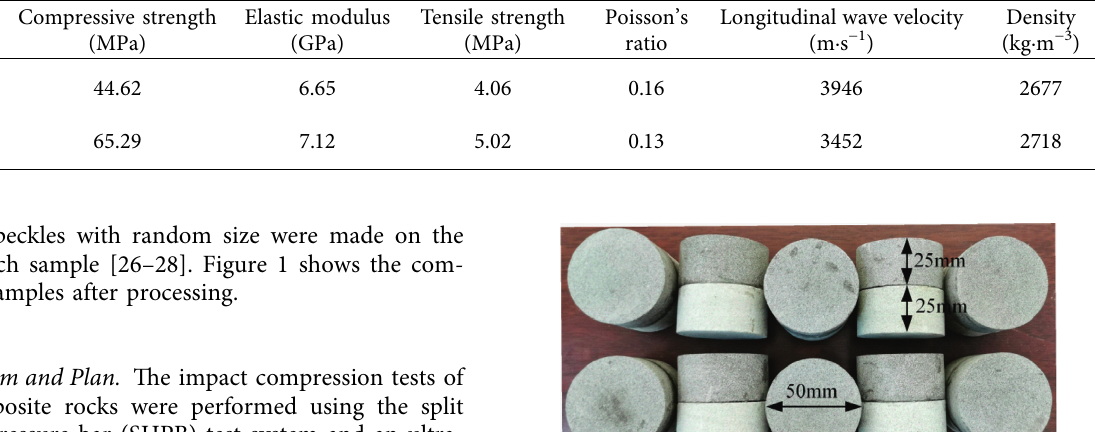
Table 1: Mechanical parameters of black sandstone and white sandstone samples.